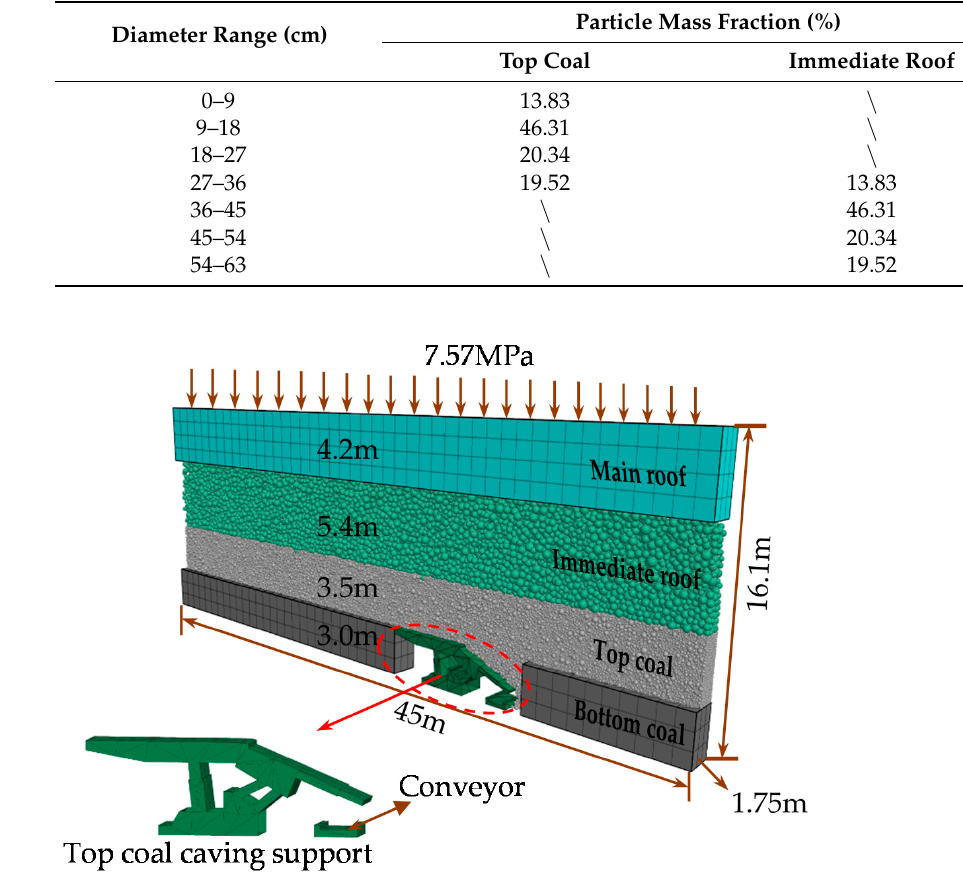
Figure 3. Numerical model [31].